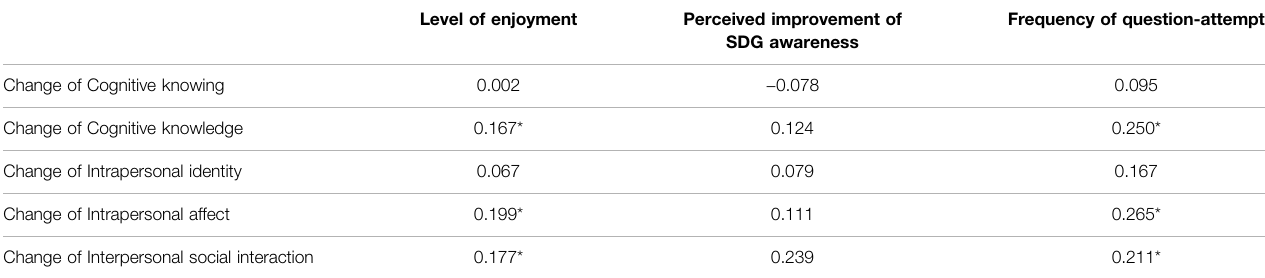
TABLE 7 | Correlation between students ’ global perspective, level of enjoyment, improved SDG awareness, and frequency of question